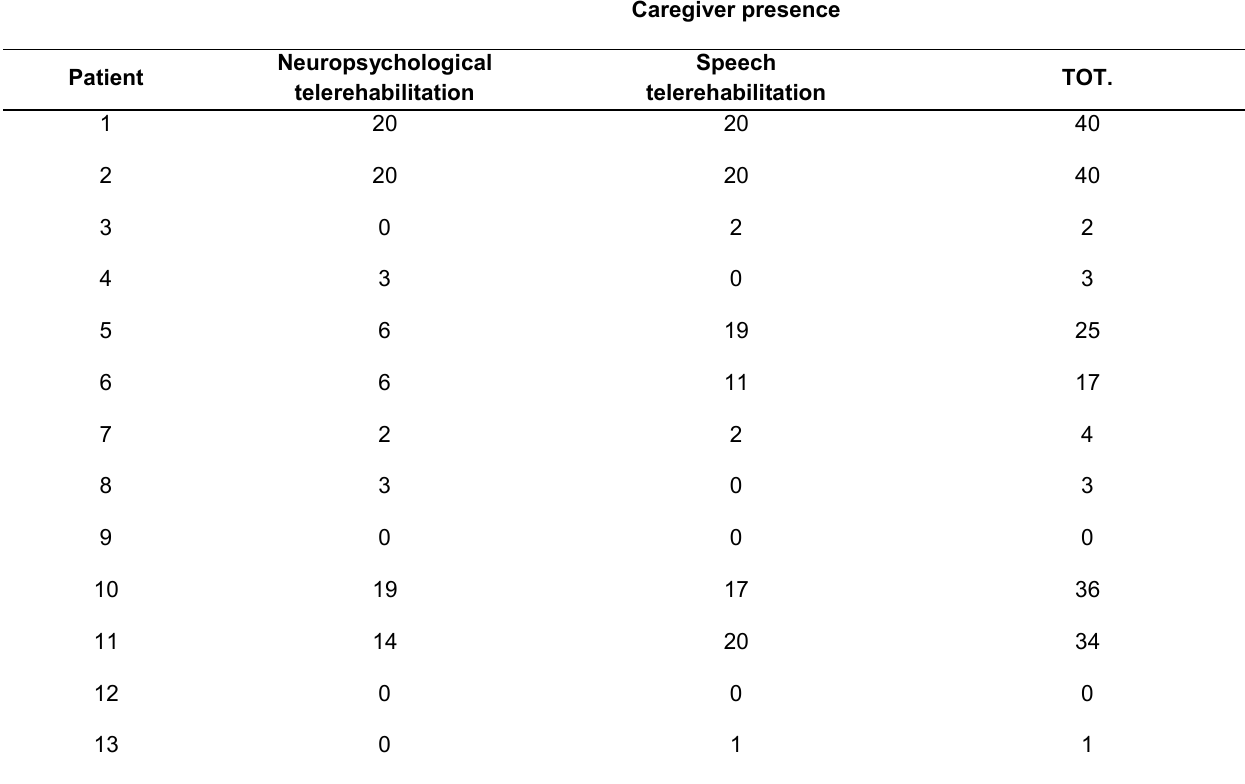
Caregiver presence Speech telerehabilitation